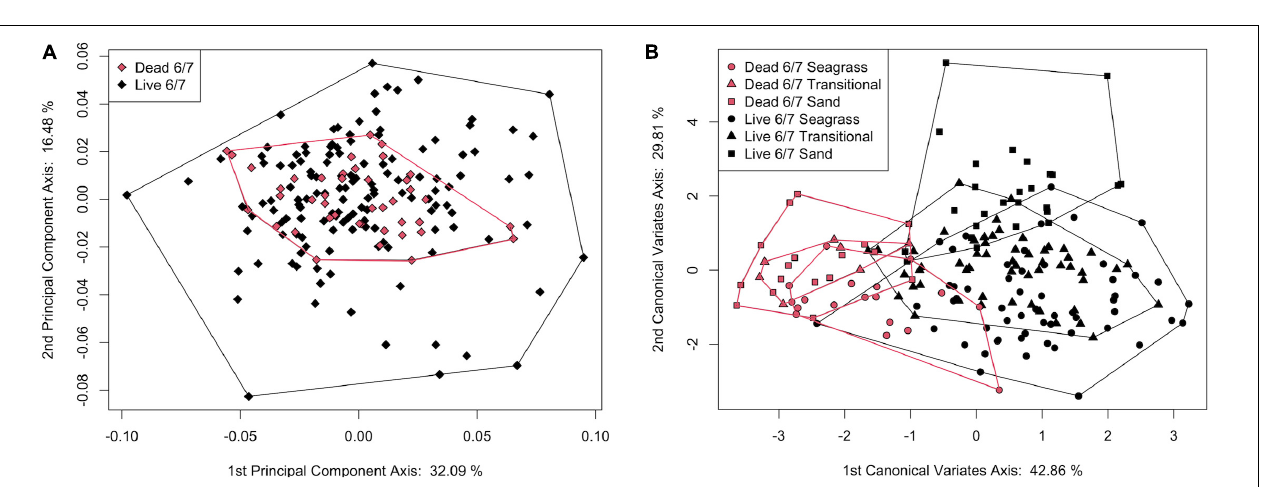
FIGURE 7 | (A) Plot of principal component axis 1 vs. principal component axis 2 for live and dead S. floridana from transects 6 and 7. (B) Plot of canonical variate axis 1 vs. canonical variates axis 2 for live and dead S. floridana specimens from transects 6 and 7 with each assigned to stability